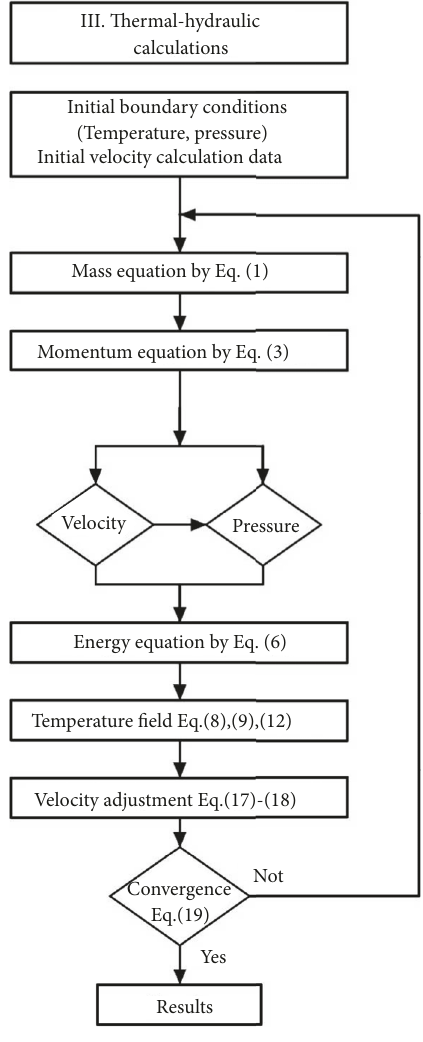
Figure 4: Calculation procedure for stages 1 and 2 in Module